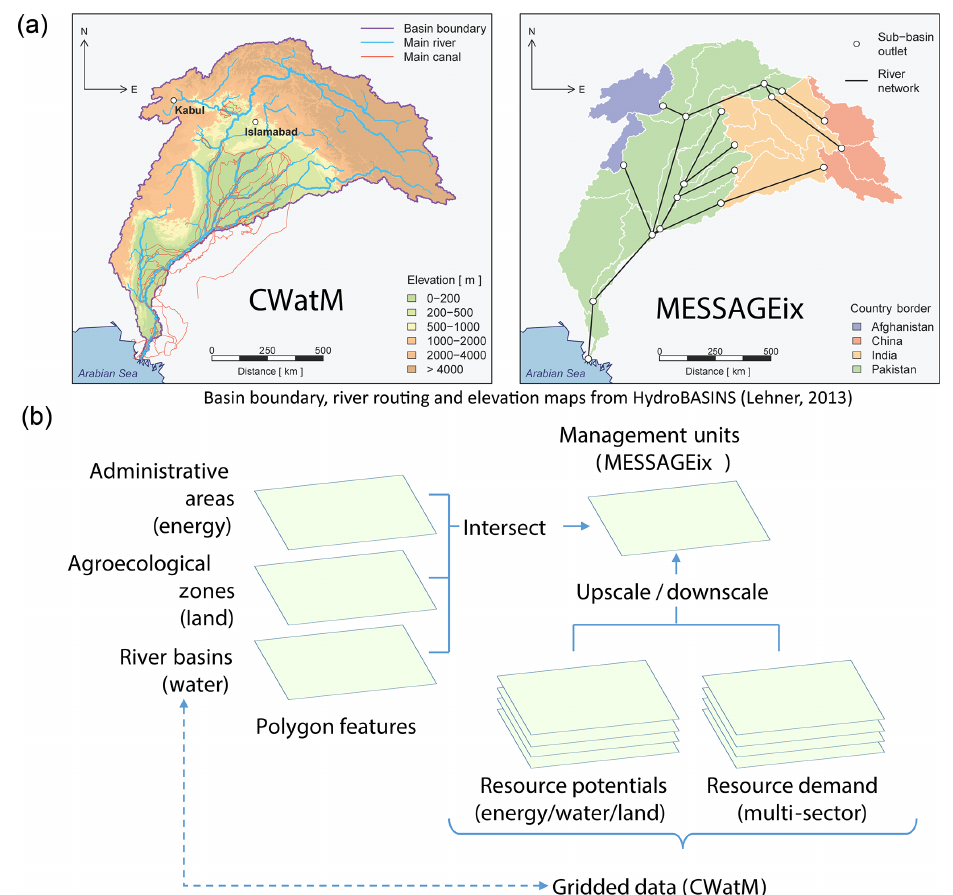
Figure 2. Delineation of spatial units in NEST. (a) The Indus River basin elevation changes, river system in CWatM (left) and the basin delineated into basin country units (BCUs) with a reduced form node-link river network for implementation in MESSAGEix (right); (b) the methodology intersecting basin boundaries, administrative regions and agroecological zones to converge on a common spatial scale and linkage to gridded resource potentials and